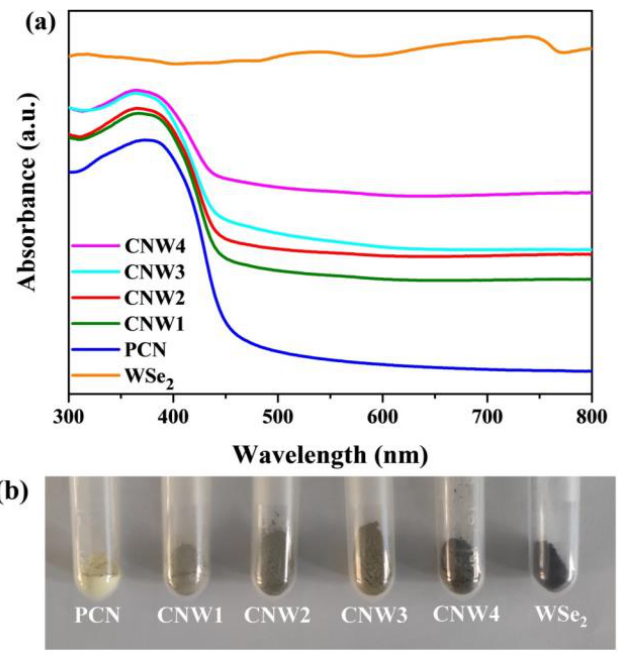
Figure 5. ( a ) UV-vis DRS spectra of PCN, CNW1, CNW2, CNW3, CNW4, and WSe 2 ; ( b ) color changes of the various samples.